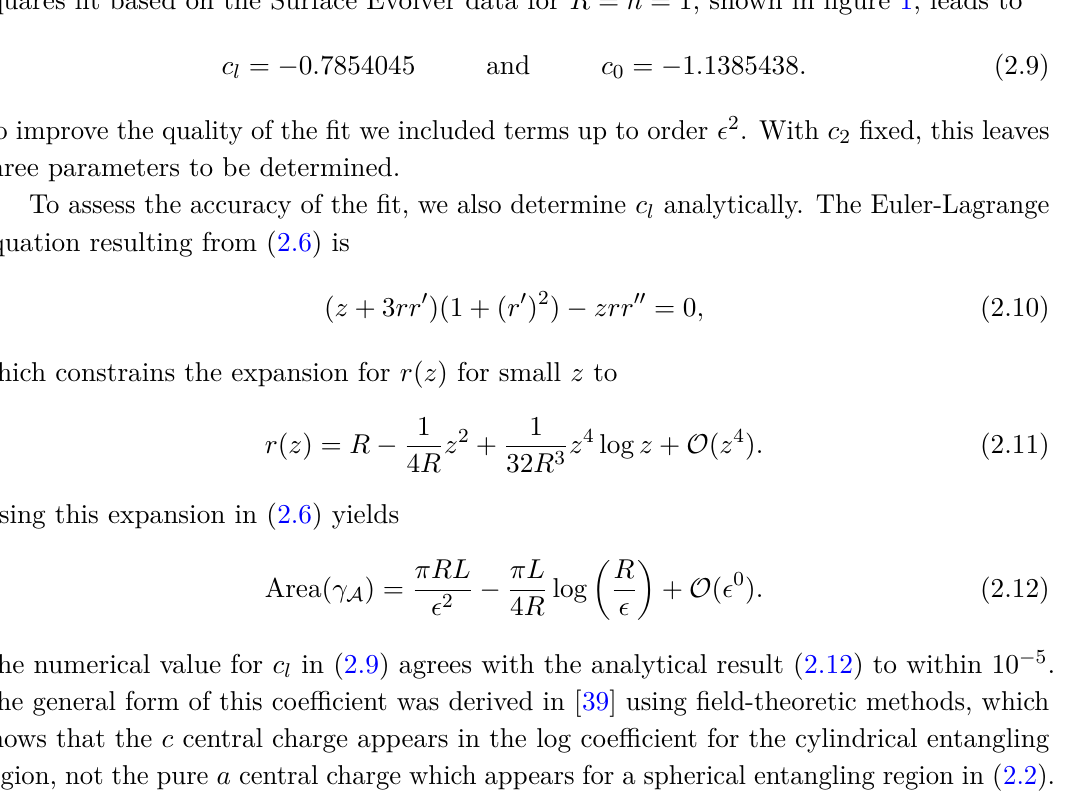
Figure 1. Left: Minimal surface for an infinite cylinder with R = 1 , obtained numerically as solution to equation (2.10). Right: Areas for 11 different (cid:15) as determined by the Surface Evolver (after subtracting the 1 /(cid:15) 2 contribution), and the best fit curve based on (2.8). term is given by the area of the entangling region divided by D − 2 for a CFT D . A least squares fit based on the Surface Evolver data for R = h = 1 , shown in figure 1, leads